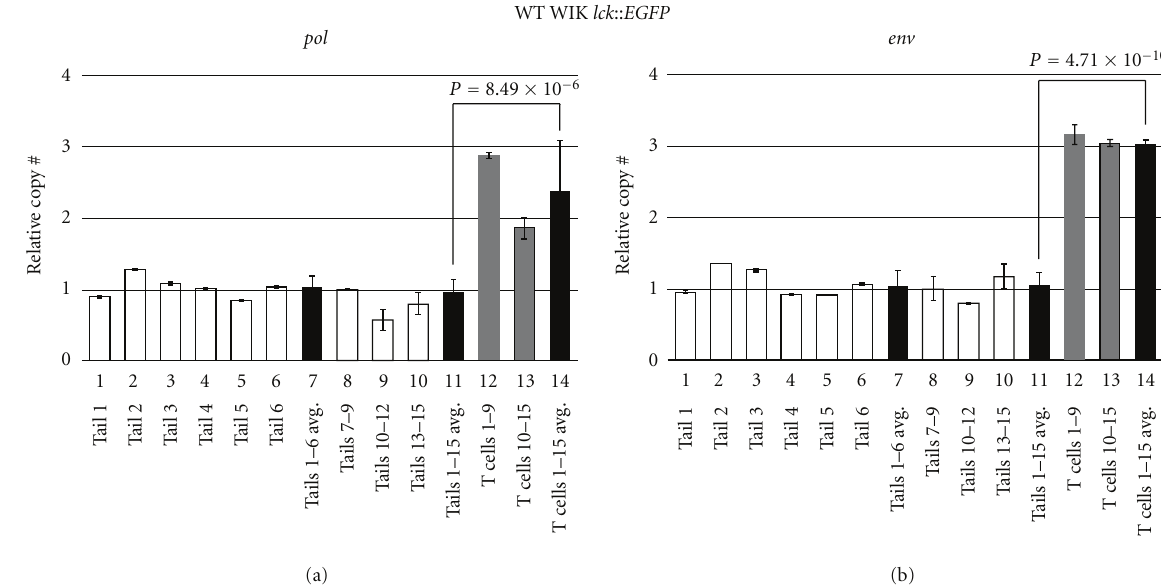
Figure 3: ZFERV amplifications in WT WIK D. rerio T cells. Genomic DNA from 15 WIK lck::EGFP fish was analyzed by qPCR of the ZFERV pol (a) and env (b) genes. White bars depict results from tail DNA of individual fish (lanes 1–6) or groups of 3 fish (lanes 8–10). Black bars show calculated means of 6 singly tested tails (lane 7) or all 15 tails (lane 11). “Tails 7–9” sample (lane 8) was arbitrarily assigned copy number equal to 1, and this DNA was used as the reference standard for all subsequent qPCRs. T cells pooled from 9 or 6 WT fish (gray bars) had 2- to 3-fold gains in ZFERV. Mean copy number was higher in T cells than tailfin DNA for the 15 fish cohort (lane 11 versus 14). Zebrafish elf2a (1 copy/haploid genome) qPCR was used to normalize pol and env results (not shown). Water-only template controls lacked detectable product (not shown). Reactions were performed in triplicate, and error bars show standard deviations ( env qPCR of tails 2 and 5 had standard deviations too small to be